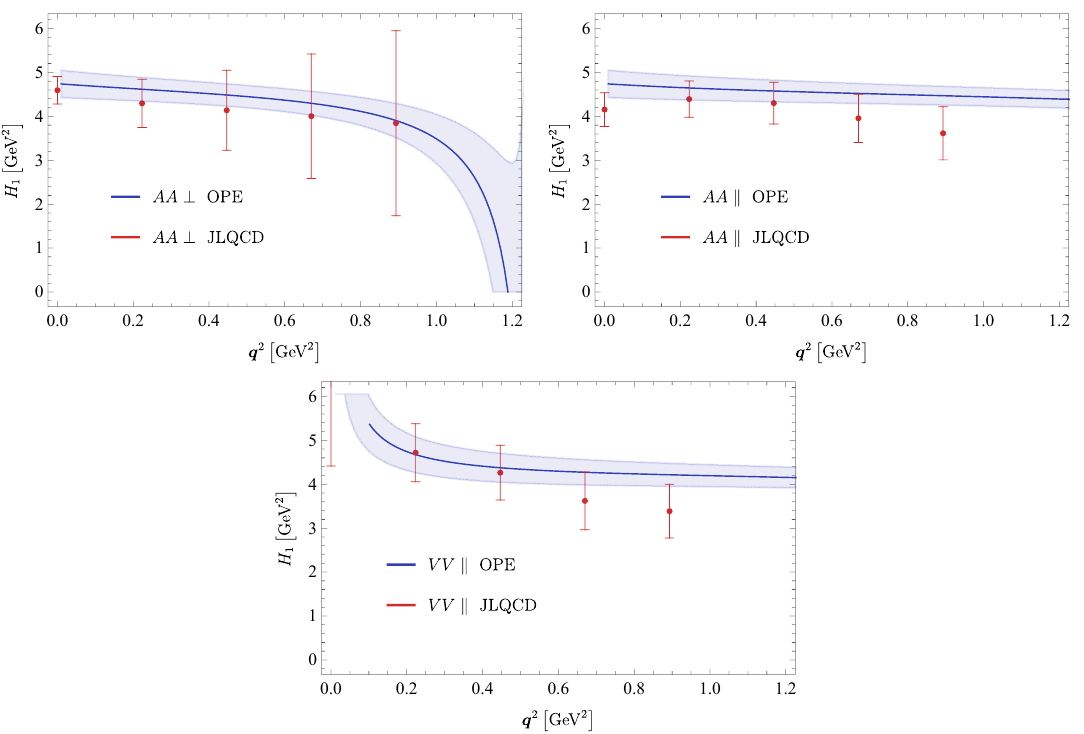
i ( q 2 ) in the various channels. The plots show the X